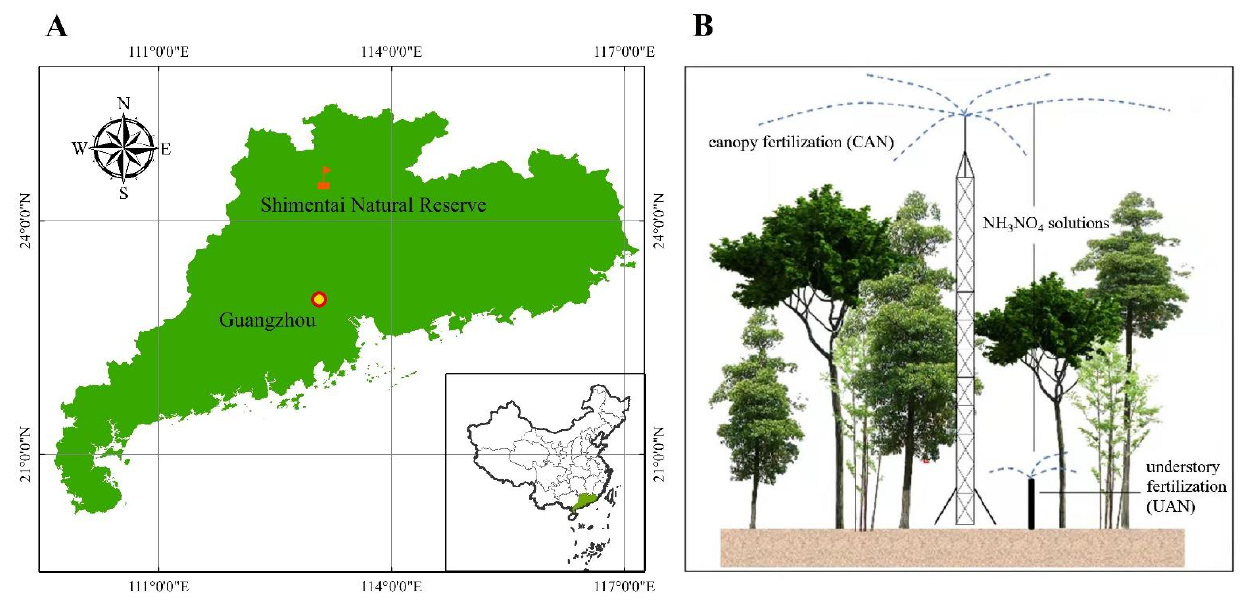
Figure 1. Location of the study site ( A ) and diagram of the simulated N addition ( B ).